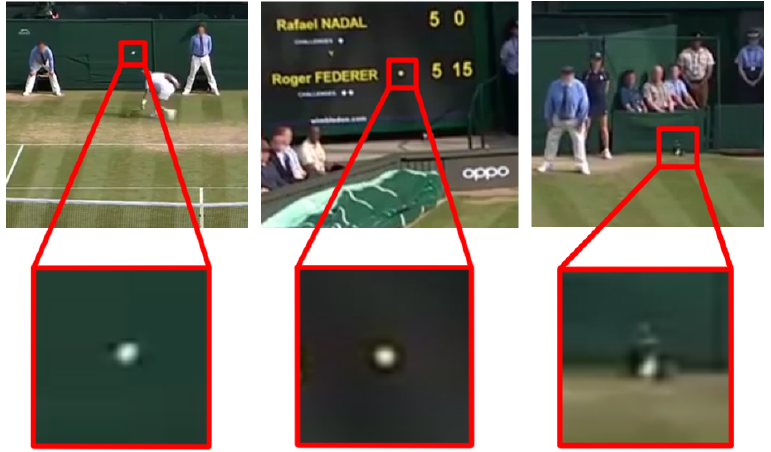
Figure 1. Three examples of patches which show how easily a small object might appear similar to other objects. Only the rightmost patch is a tennis ball, while the other two objects appear similar to it without actually being a tennis ball. Without a mean to discriminate the real object from potential false positives, a neural network might fail to learn how to recognise the sought object.